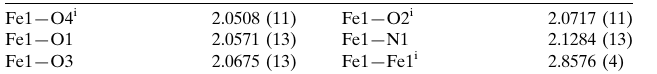
Selected bond lengths (A˚